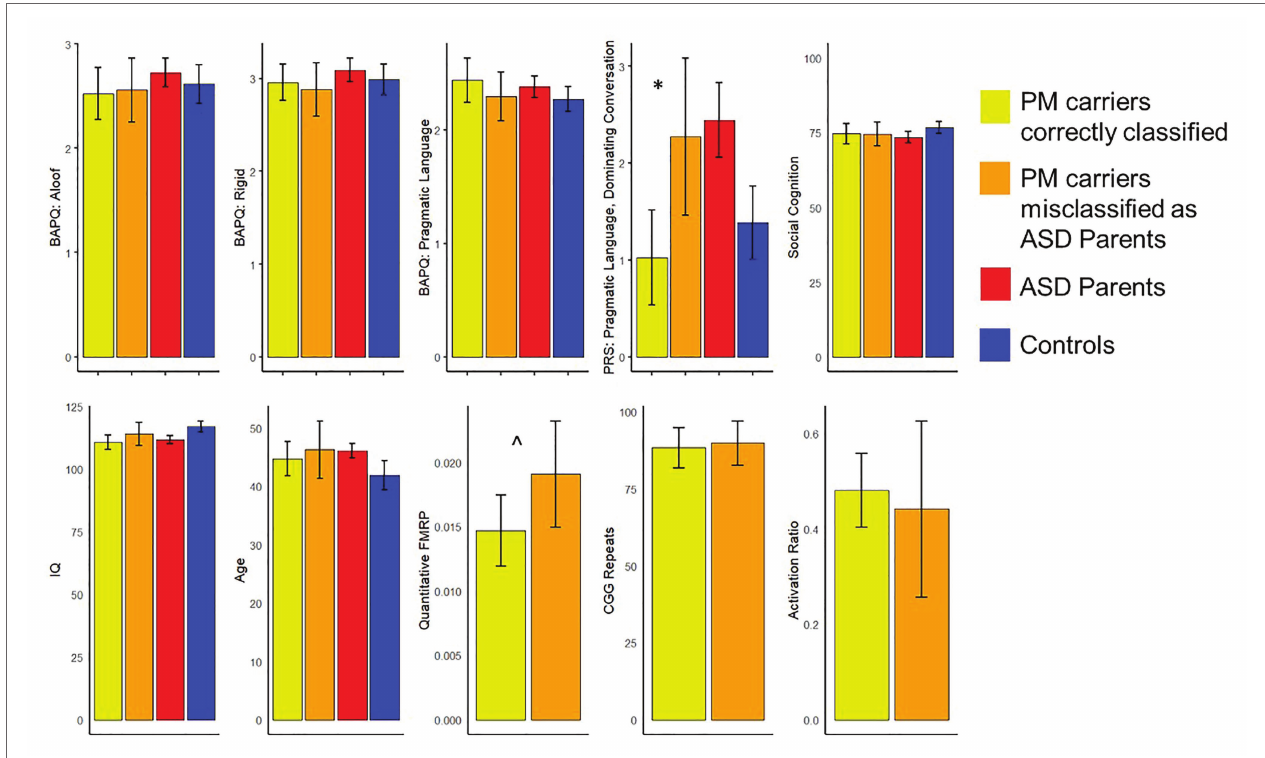
FIGURE 3 | Comparisons of clinical-behavioral and FMR1 -related variables between the premutation (PM) carriers who were misclassified as ASD parents and those who were correctly classified (* p < 0.05, ^ p < 0.10). Of note, controls are not included in comparisons related to broad autism phenotype (BAP) features, and ASD parents and controls were not included in comparisons related to FMR1 molecular-genetic variation.